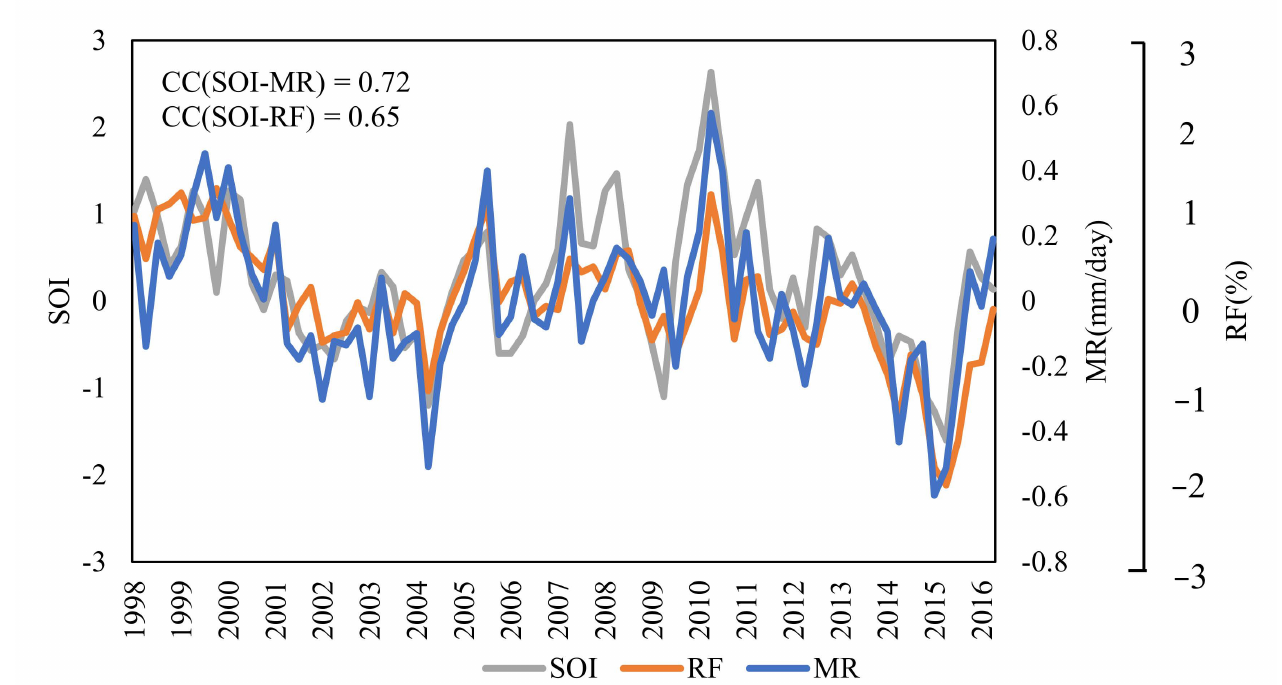
Figure 4. Correlation between SOI and MR and RF anomalies of land in southern